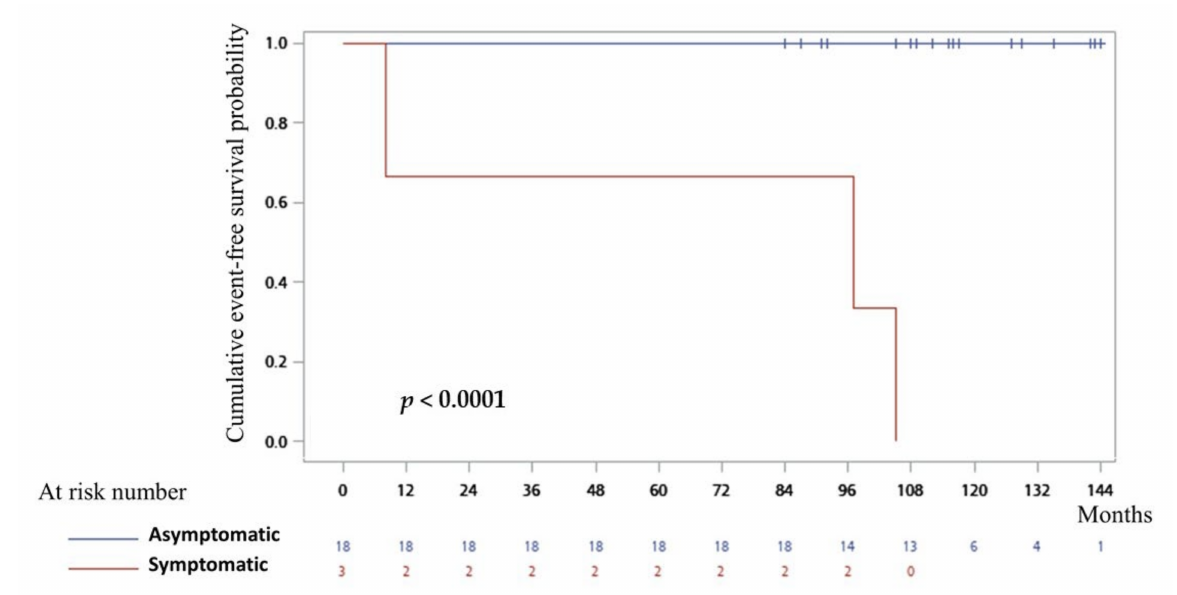
Figure 5. Cumulative survival curves during the follow-up period. Kaplan–Meier analysis of arrhythmic events (sudden cardiac death or documented ventricular fibrillation) during the follow-up depending on clinical presentation with symp- tomatic (aborted sudden cardiac death or syncope of suspected arrhythmic origin) or asymptomatic individuals when a fever-induced Brugada ECG pattern was identified. The difference between the two groups was statistically significant (log-rank p <